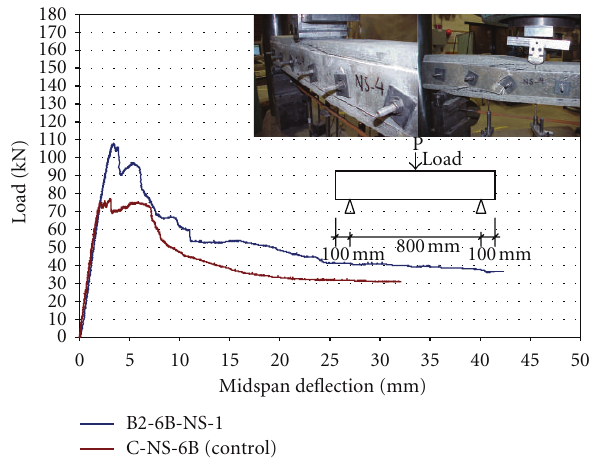
Figure 31: Load versus midspan deflection of RC beam